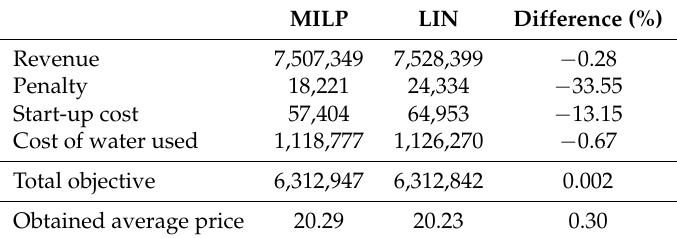
Table 2. Results from the simulation. The total objective is Revenues–Penalty–Start-up costs–Cost of water used. The obtained average price is found by dividing the total income by the amount produced. Numbers are given in e , prices in e /MWh. MILP LIN Difference (%) Revenue 7,507,349 7,528,399 − 0.28 Penalty 18,221 24,334 − 33.55 Start-up cost 57,404 64,953 − 13.15 Cost of water used 1,118,777 1,126,270 − 0.67 Total objective 6,312,947 6,312,842 0.002 Obtained average price 20.29 20.23